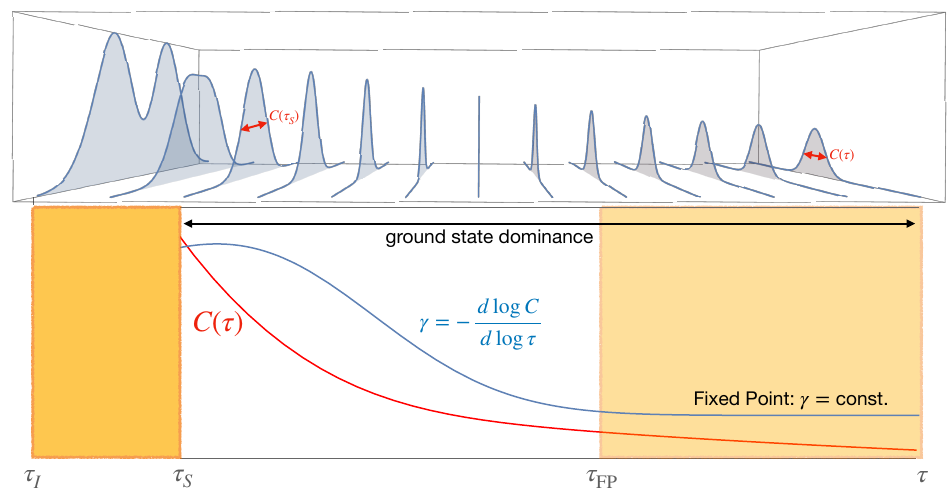
Figure 1 . We illustrate time-dependent scaling behavior and its connection to adiabaticity. On the top, we show a typical evolution of a distribution function in the present work. Below, we show the temporal evolution of the characteristic scale C and its associated scaling exponent γ in red and blue solid curves, respectively. Though the evolution of the distribution function begins at τ I , the scale and exponents are only well-defined after the time τ S when the distribution function reaches its self-similar scaling form. Although the scaling exponent γ will eventually approach its fixed point value at τ FP , the distribution function may take the scaling form at τ S < τ FP . Within the present set-up, we find the emergence of scaling behavior around τ S is associated with the decay of excited modes, as will be explained throughout the main text. The ground state mode can then be associated with the scaling form of the distribution, giving the dominant contribution to the state of the system during the scaling stage, and hence the distribution function’s self-similar evolution becomes equivalent to adiabatic evolution. We note that, in this scenario, all of this happens well before the system becomes hydrodynamic: τ FP (cid:28) τ Hydro